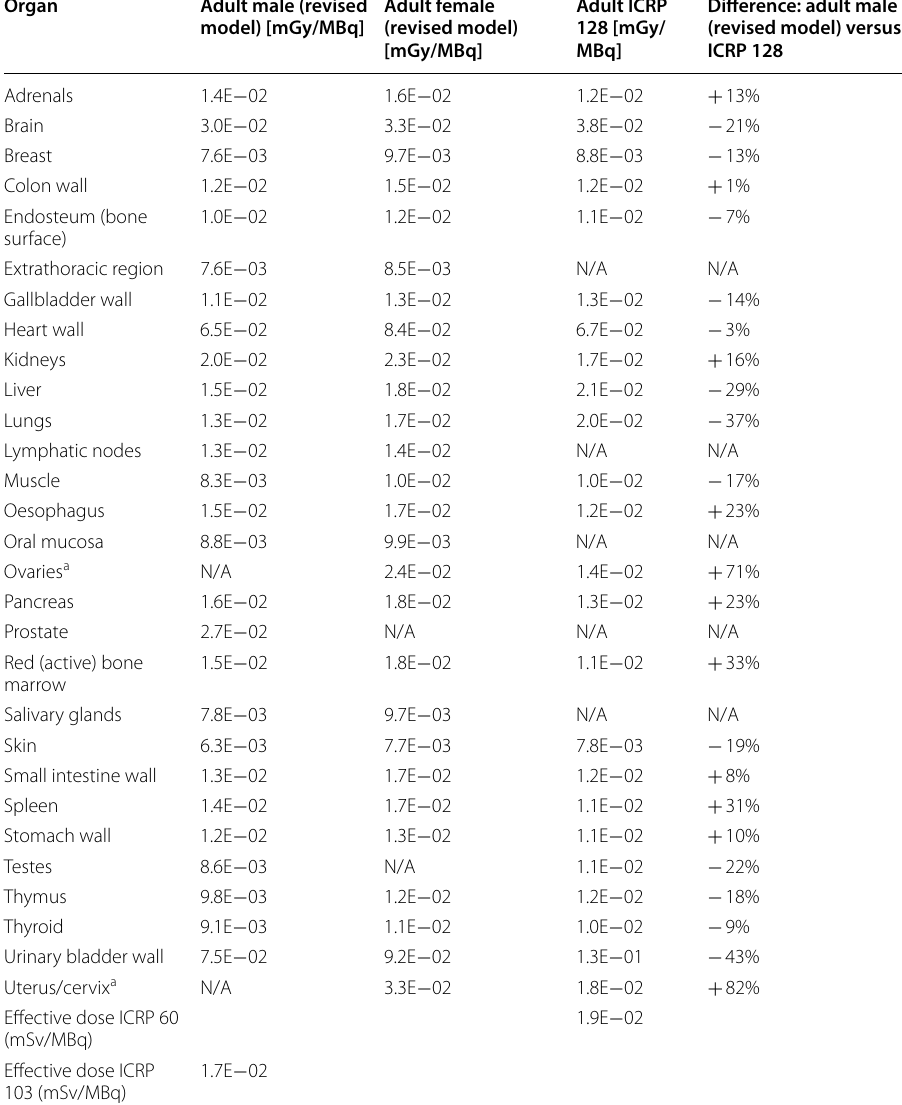
Table 4 Dose coefficients for absorbed organ doses [mGy/MBq] and the effective dose [mSv/MBq] for adults administered with 2‑[ 18